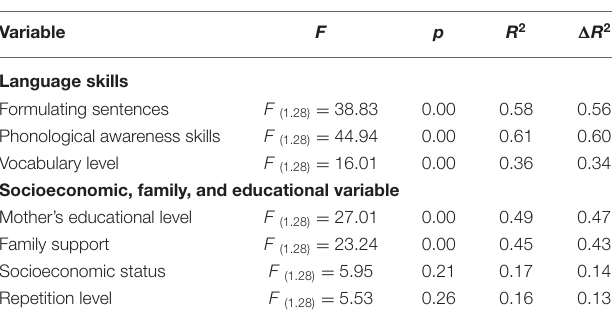
TABLE 7 | Linear regressions: reading accuracy. TABLE 8 | Linear regressions: reading